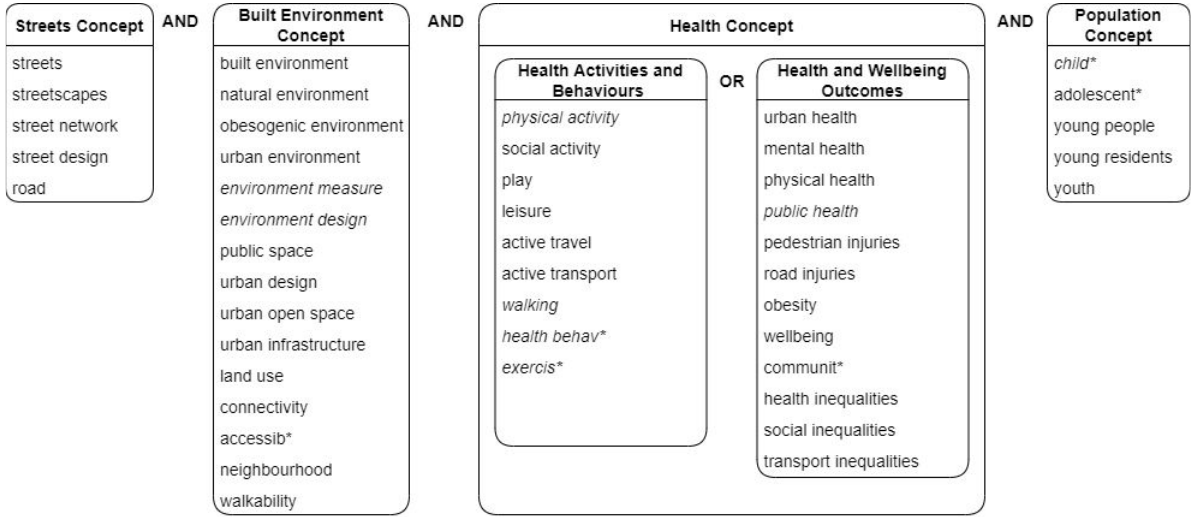
Figure 1. Keywords by concept for the search strategy. (Italics indicate Medical Sub-Heading terms and * was included to capture permutations).